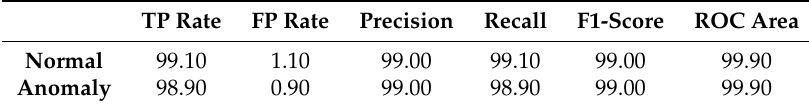
Table 34. Classification report for Bagging Random Forest.